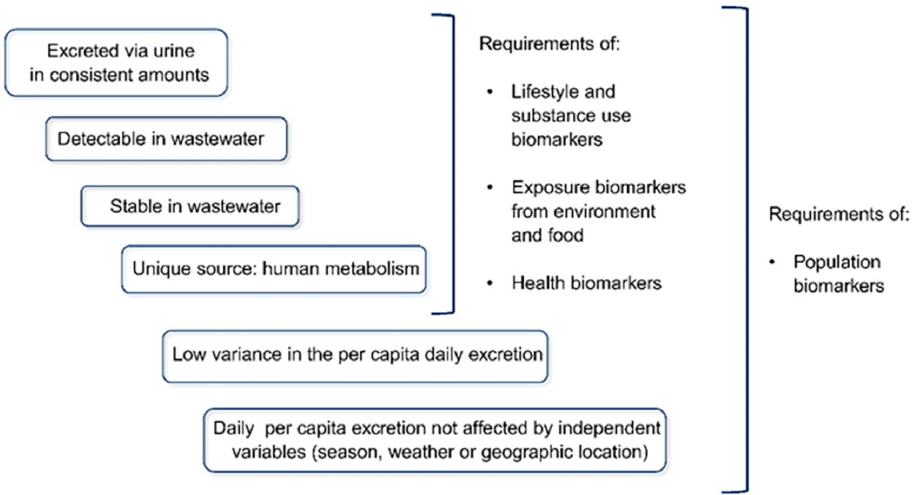
Figure 11. Guidelines for selecting a biomarker in wastewater diagnostics. (Re-printed from Gracia-Lor et al. [99]. Copyright (2017), with permission from Elsevier).